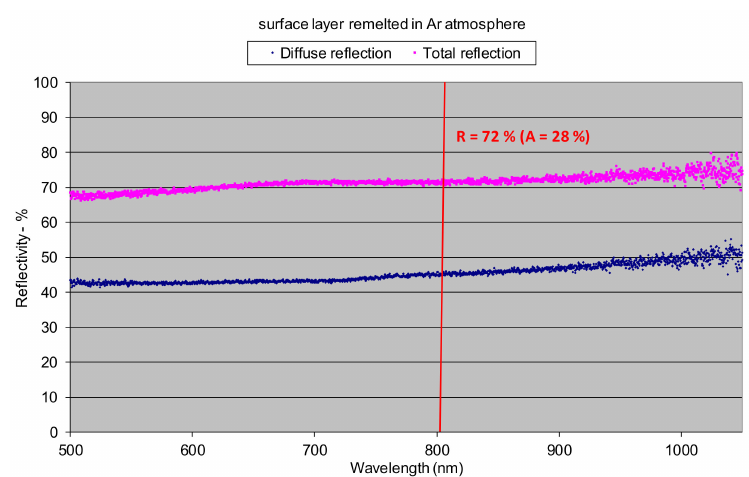
Figure 10. Reflectivity of the surface layer produced by laser melting of titanium alloy Ti6Al4V by HPDDL in pure argon, determined at room temperature (bead No. 8 in Figure 9, parameters of processing; laser power 1.8 kW, scanning speed 400 mm / min, energy input 270 J / mm, surface roughness Ra 1.1).